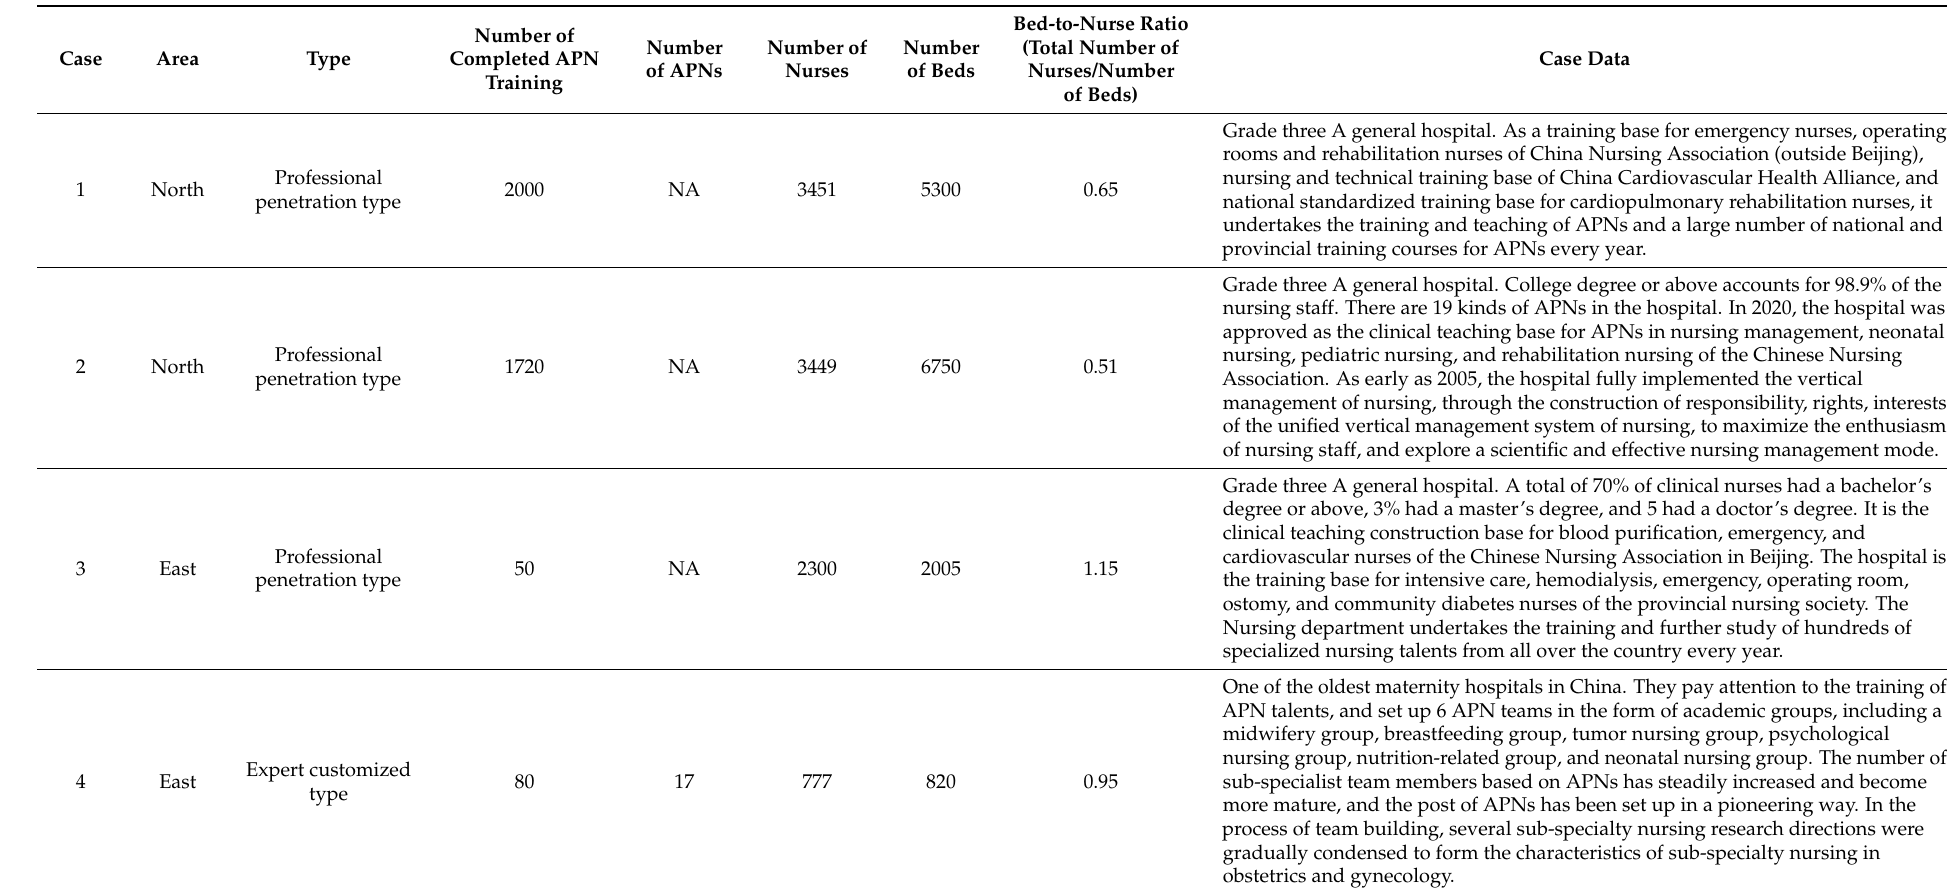
Table A1. Data of the 18 cases of APNs Trained and Employed in Chinese